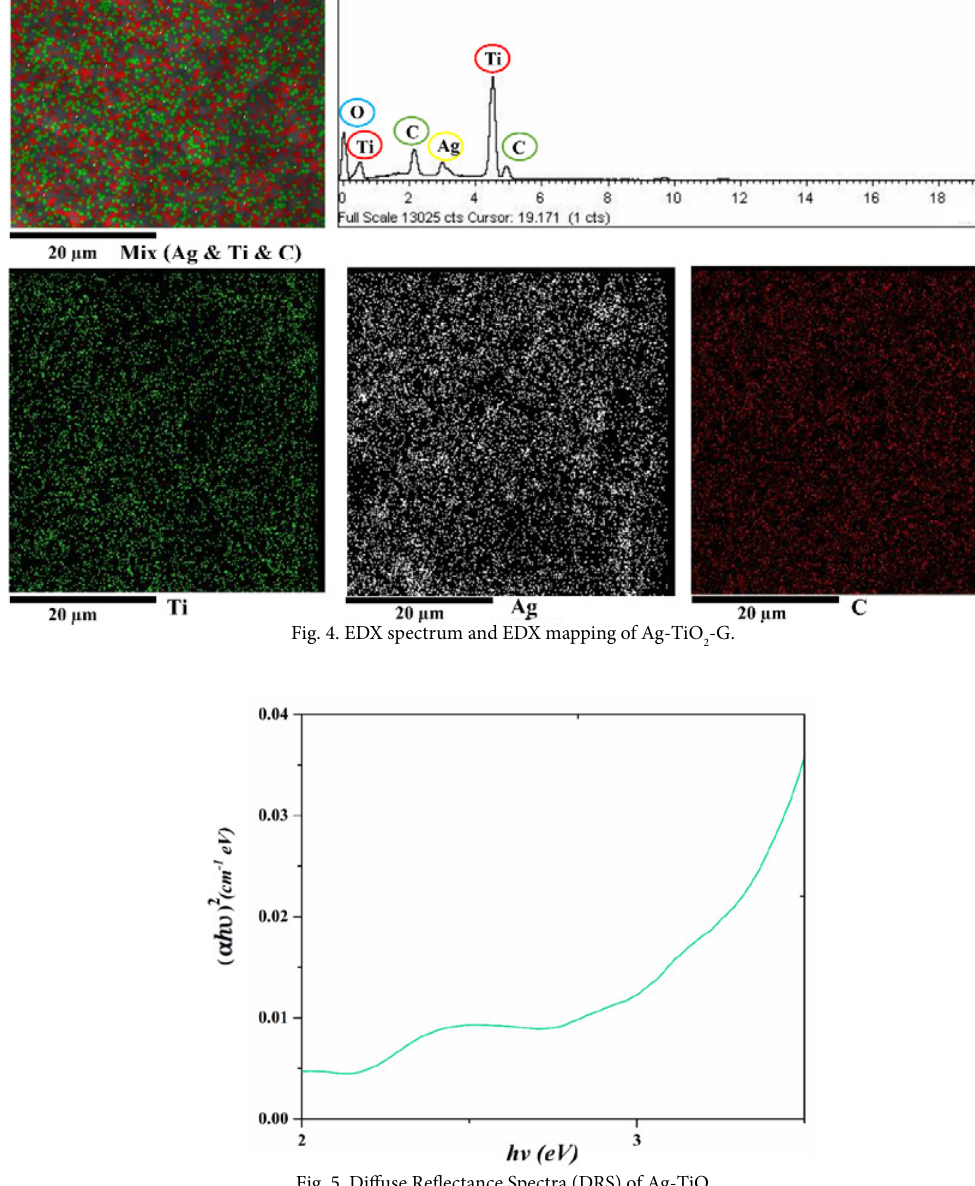
Fig. 5. Diffuse Reflectance Spectra (DRS) of Ag-TiO